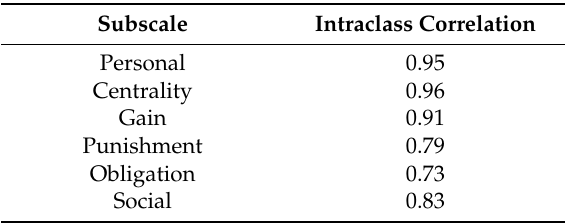
Table 5. Test-retest Reliability of the CROI in Study 2.